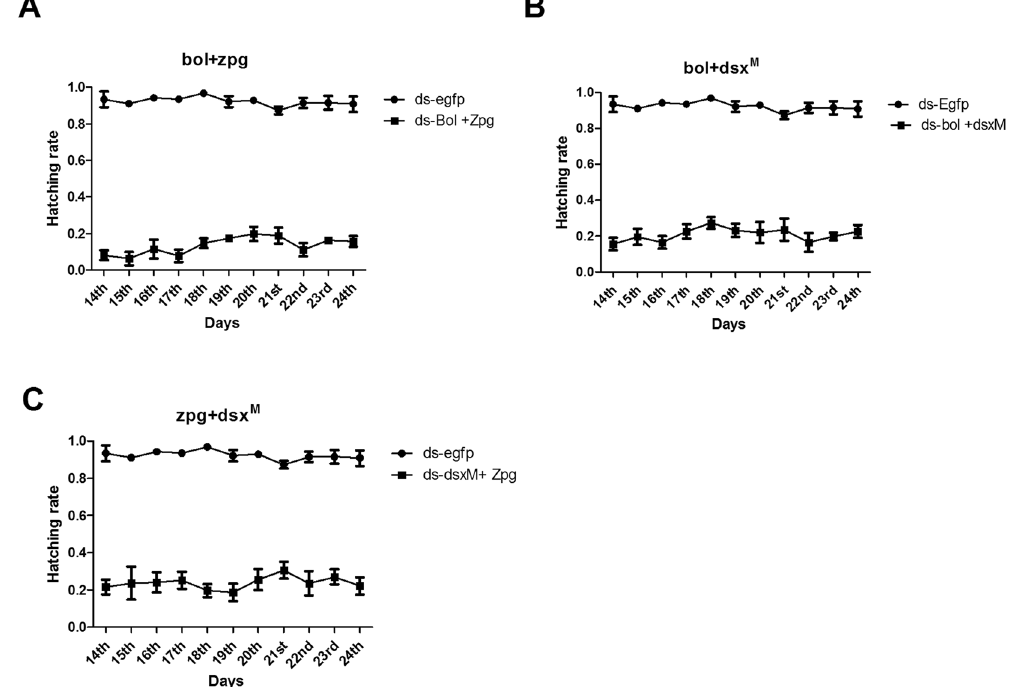
Figure 4. Egg hatching rate per day in response to a synergistic effect of two dsRNAs. The average number of eggs hatched per day between candidate gene dsRNA combinations and ds-EGFP treated flies ( A ) boul + zpg ( B ) boul + dsx M & ( C ) zpg + dsx M ). Three biological replicates were performed and significant differences in egg hatching rates were found.